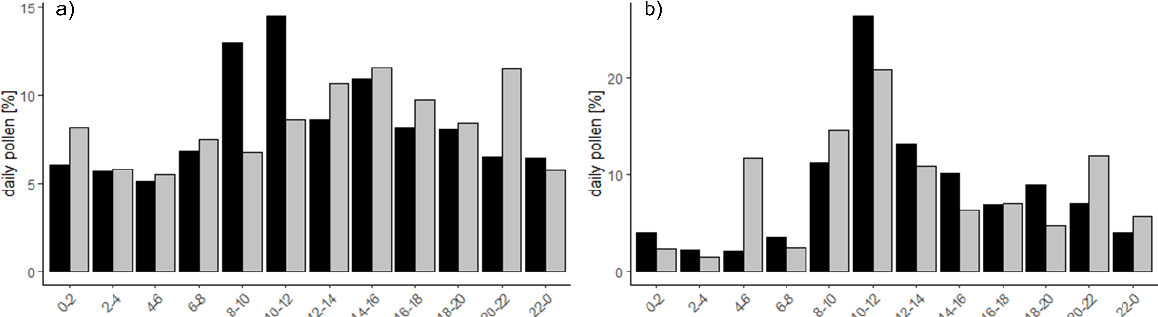
Figure 9. Diurnal pattern of Poaceae pollen concentration recorded by both 7-day volumetric traps, grey—US, black—SRS ( a ) during 2019; ( b ) during the week of PVAS sampling (13 June–19 June 2019).